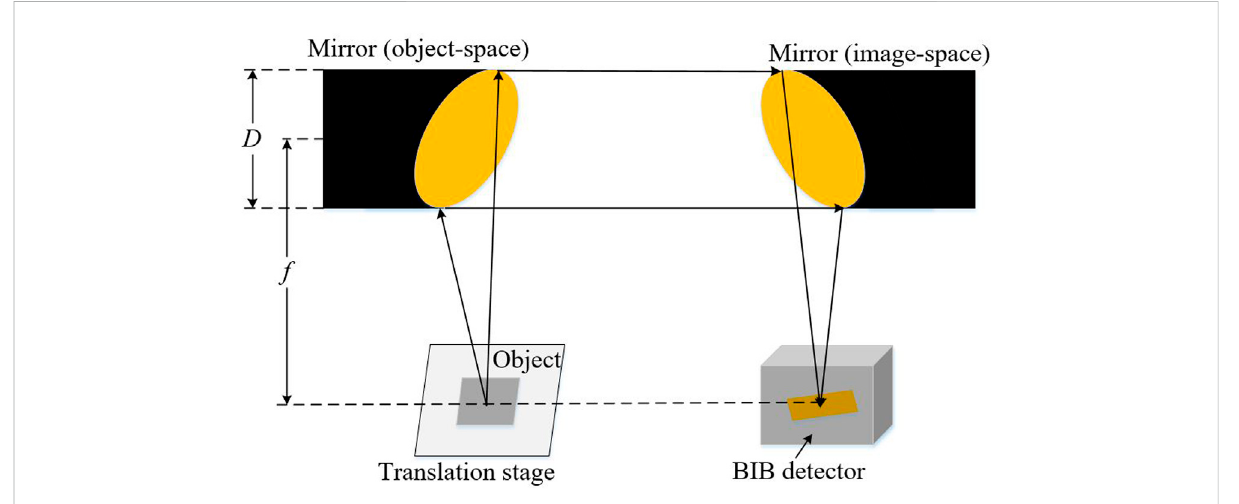
FIGURE 5 The diagram of the optical imaging system.